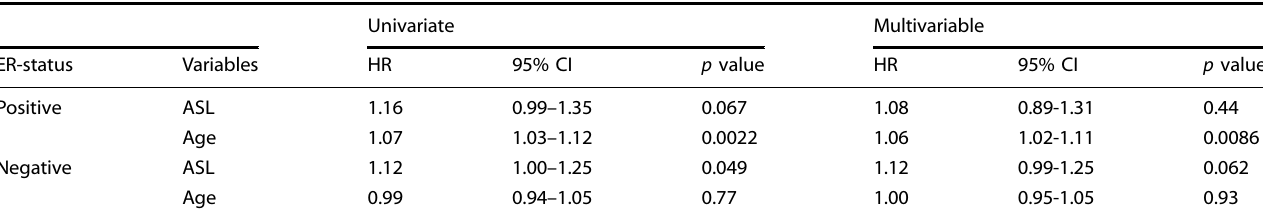
Table 1. Univariate and multivariable Cox proportional hazard models suggest proteomic levels of ASL are signi fi cantly associated with survival of ER-negative breast cancer